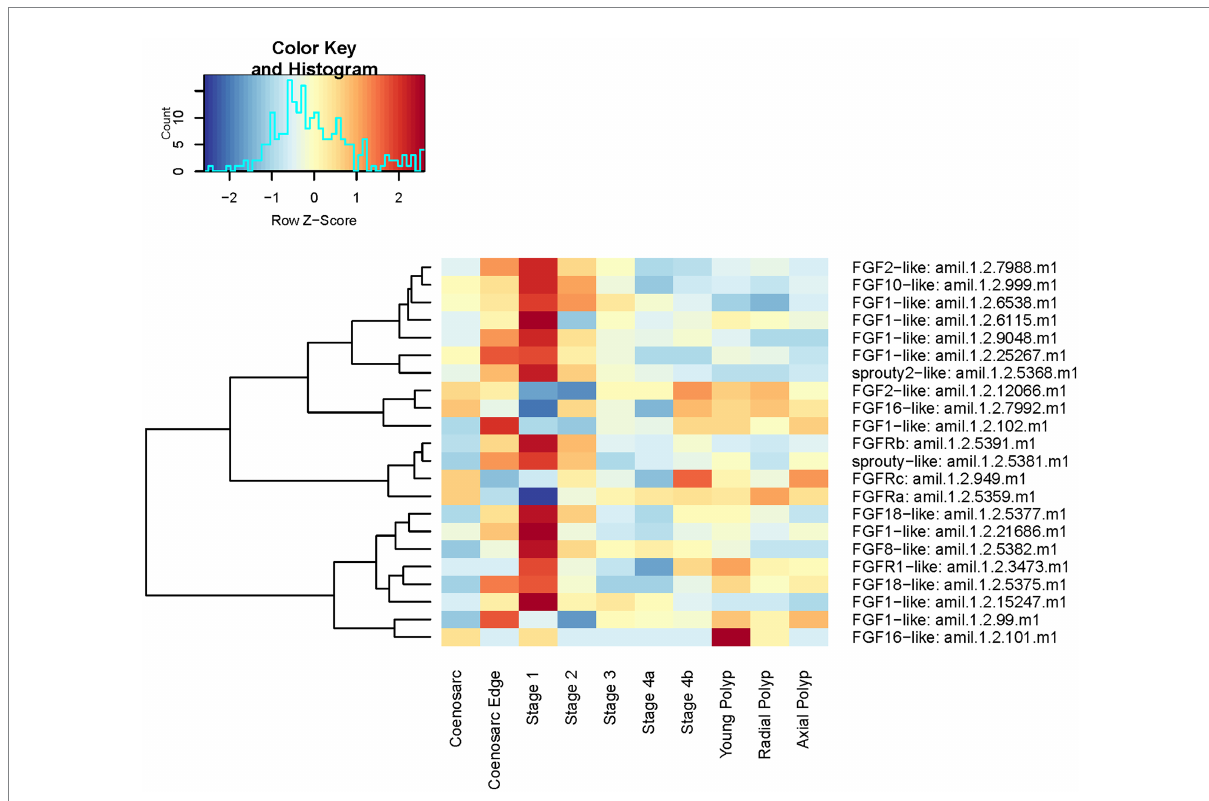
FIGURE 8 Expression heatmap of core components of the A. millepora FGF pathway. Samples are pooled according to regeneration stage and morphologically distinct colony part. Colour denotes an increase (red) or decrease (blue) in expression based on the z-score. The Histogram shows the distribution of the z-scores on the